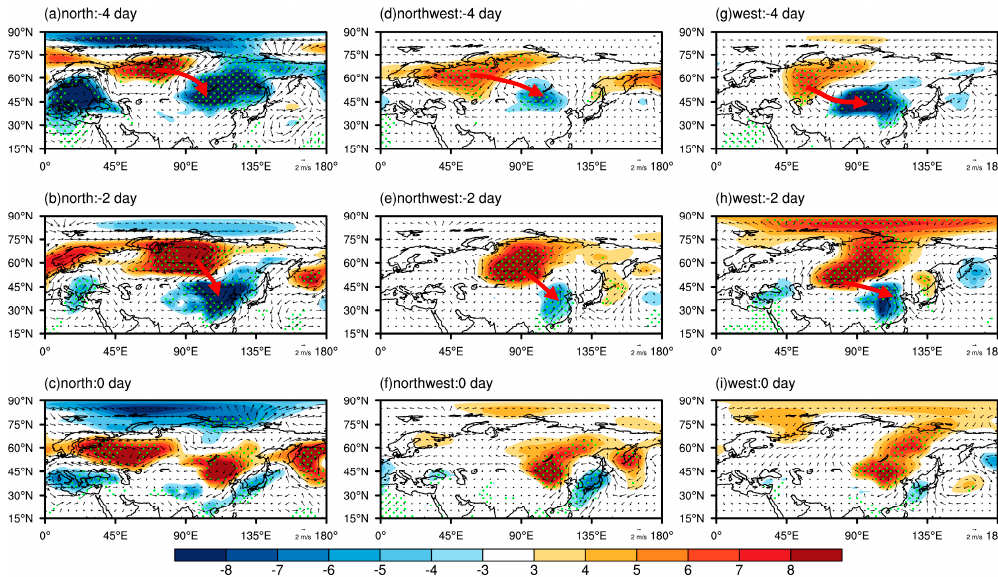
Figure 8. Sea level pressure (shaded areas; unit: hPa) and 850 ‐ hPa wind anomalies (vectors; unit: m/s) from day − 4 to day − 2 relative to cold surge occurrences of the north ( a – c ), northwest ( d – f ), and west ( g – i ) types. Red arrows indicate the expansion of the Siberian High.